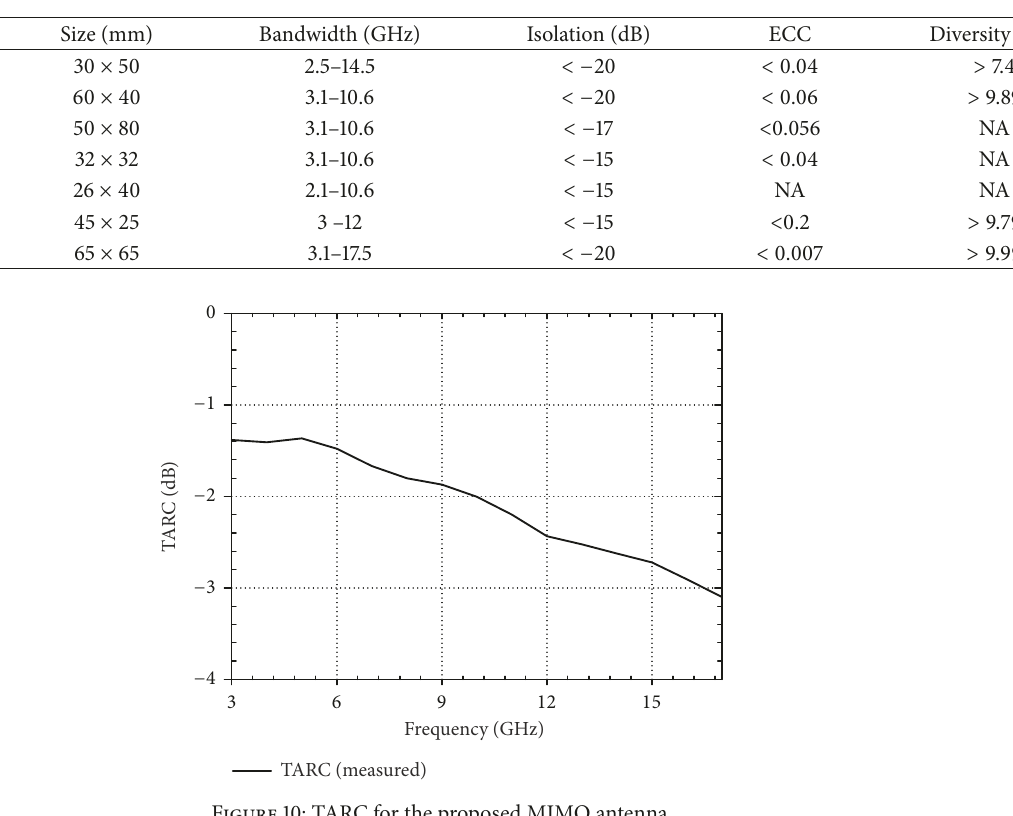
Table 2: Performance Comparison of Existing Antennas.